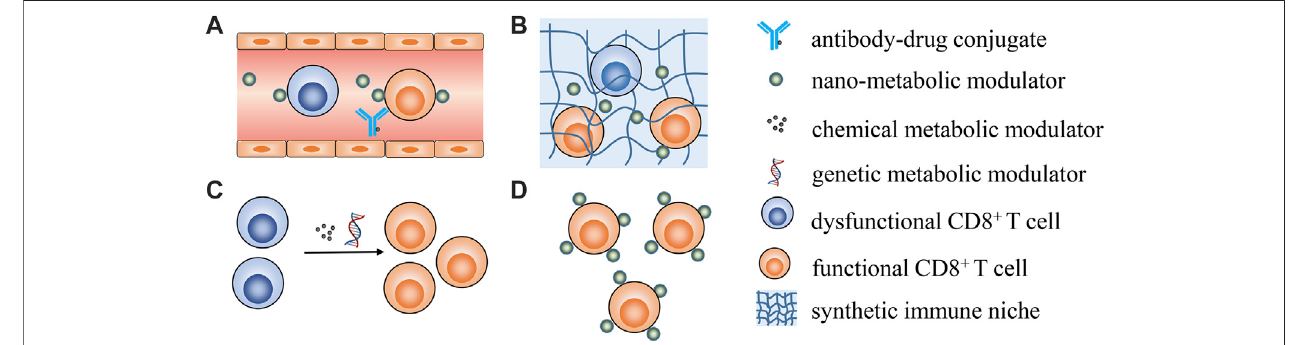
FIGURE 1 | Possible strategies for metabolically manipulating CD8 + T cells to enhance cancer immunotherapy. (A) targeting peripheral CD8 + T cells utilizing antibody-drug conjugates or antibody-modi fi ed nanoparticles to speci fi cally modulate CD8 + T cells metabolism; (B) employing synthetic immune niche to recruit CD8 + T cells and successive metabolic modulation; (C) leveraging genetic and pharmacological interventions to transiently modulate T cell metabolic properties ex vivo to generatemetabolic fi tnessTcellsforACT; (D) functionalizingCD8 + Tcellswithnano-vehicles loadingmetabolicmodulators exvivo forreal-time Tcellsmetabolism modulation in vivo after